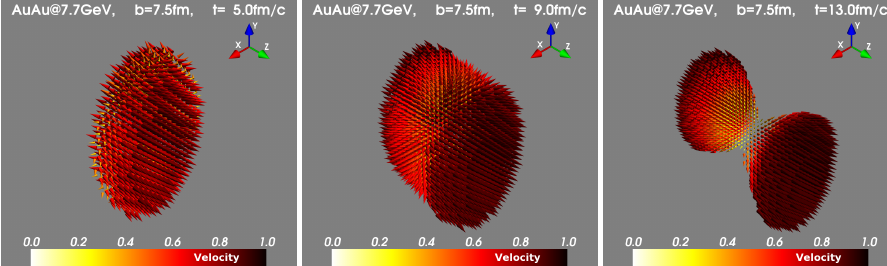
√ s NN = 7.7GeV with